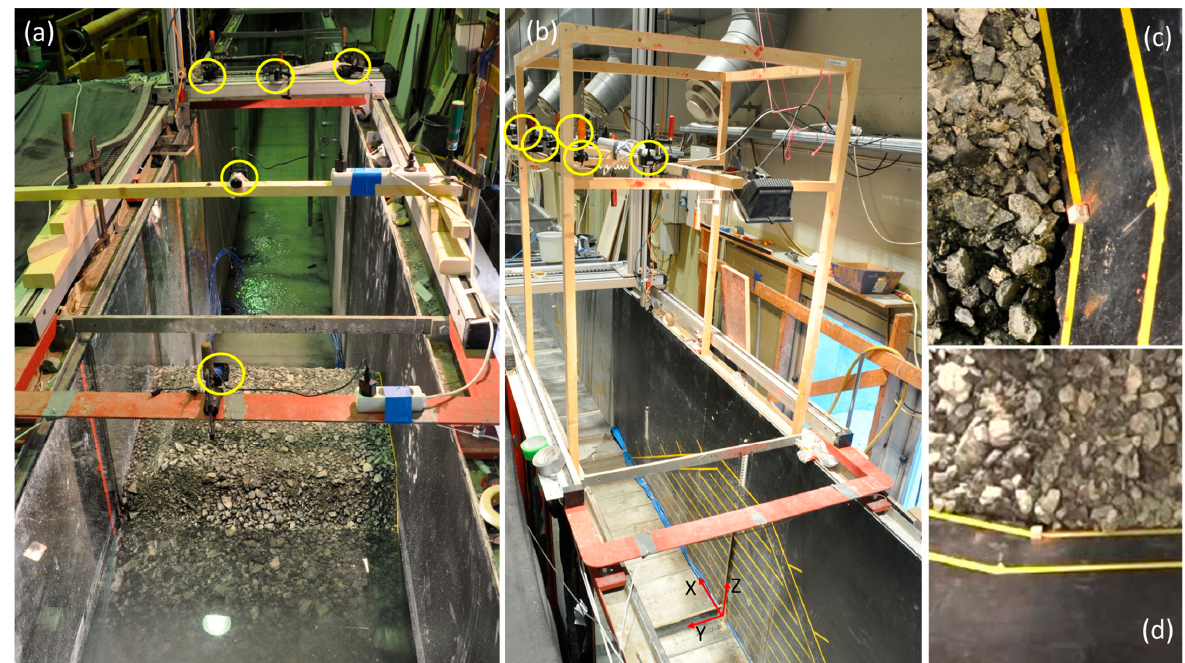
Figure 3. Camera rig setups ( a ) Model U1-U3 ( b ) Model U4-H3, camera locations indicated by yellow circles, coordinate system definition shown on ( b ) with red arrows and axis labels ( c ) shows DSLR image of a GCP cube ( d ) shows video frame of the same GCP cube.